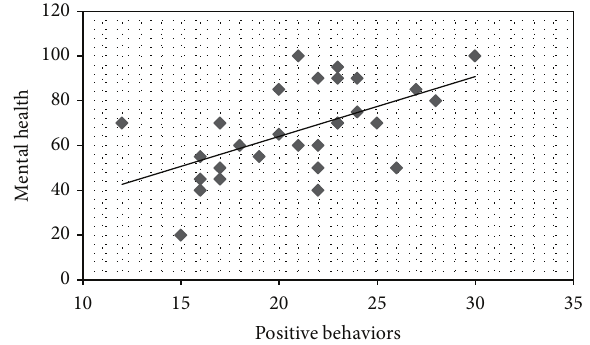
Figure 3: Correlation between mental health and positive behav- iors. 𝑟 = 0.559 , 𝑃 = 0.002